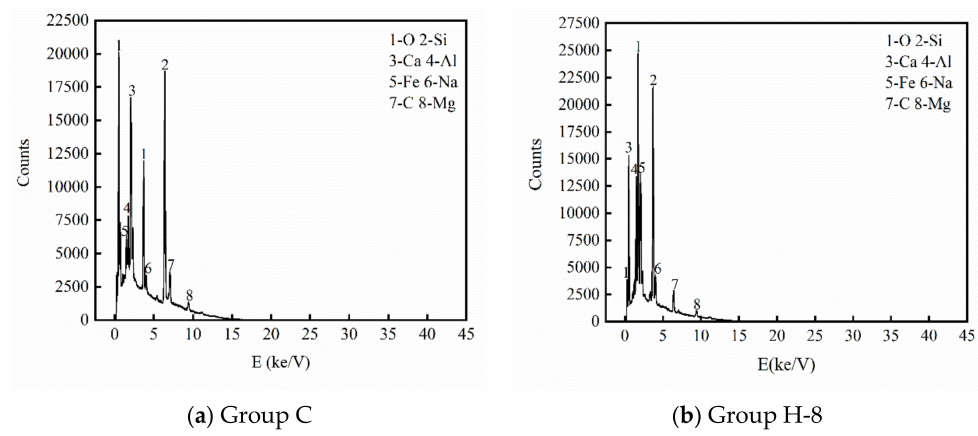
Figure 7. EDS text of HFRC. Table 8. EDS quantitative analysis of